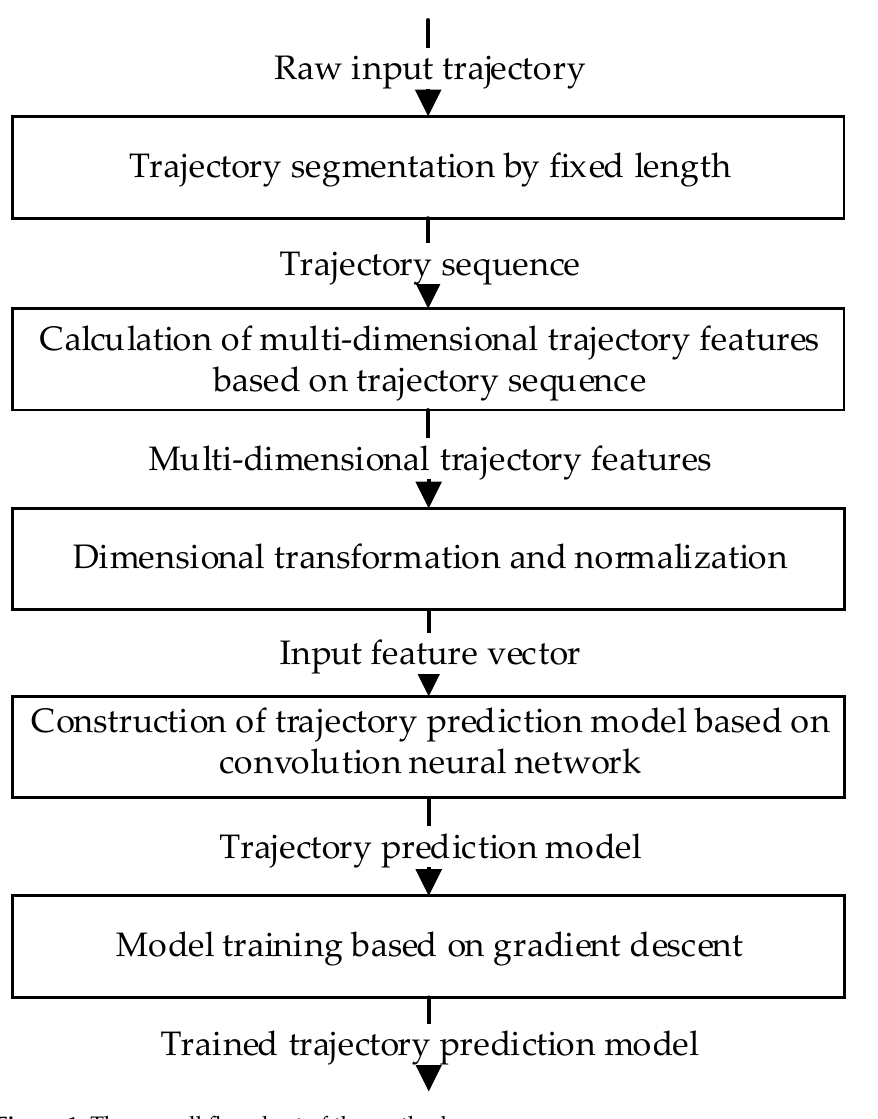
Figure 1. The overall flowchart of the method. Three essential components of the methodology are detailed below. Section 3.1 deals with the extraction of multi-dimensional trajectory features, Section 3.2 with the architecture of CNN models, and Section 3.3 with the training method for the network